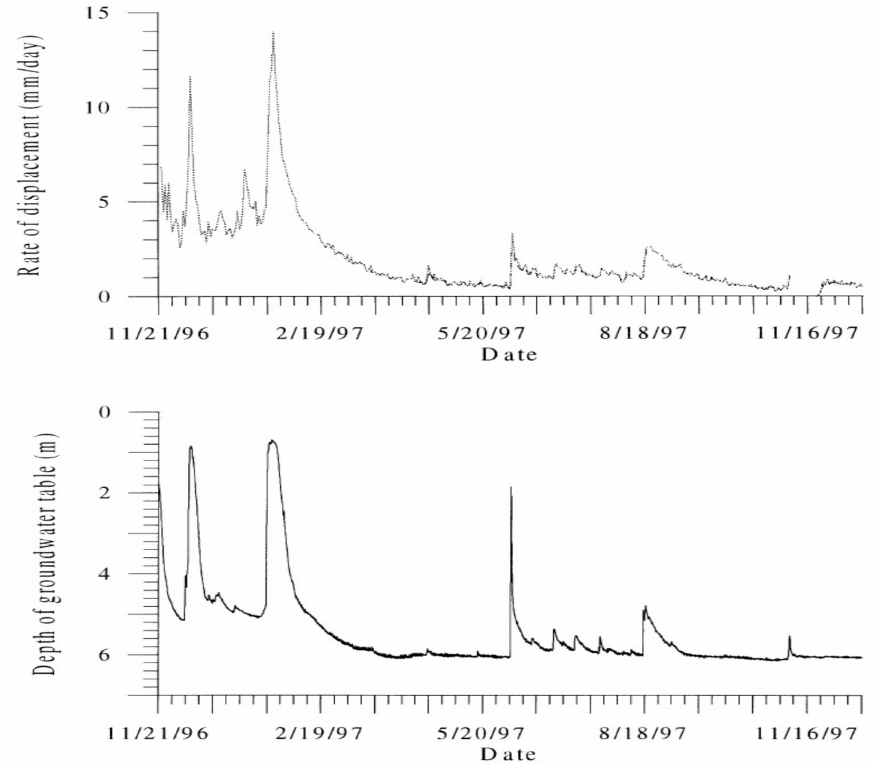
Figure 14. Measurements at borehole S2. Above: rate of displacement derived from the wire exten- someter. Below: groundwater table fluctuation measured by the piezometer. A perfect synchronism between rate and water level can be appreciated. This correlation means that groundwater has a big influence in the balance of forces controlling the landslide dynamics.